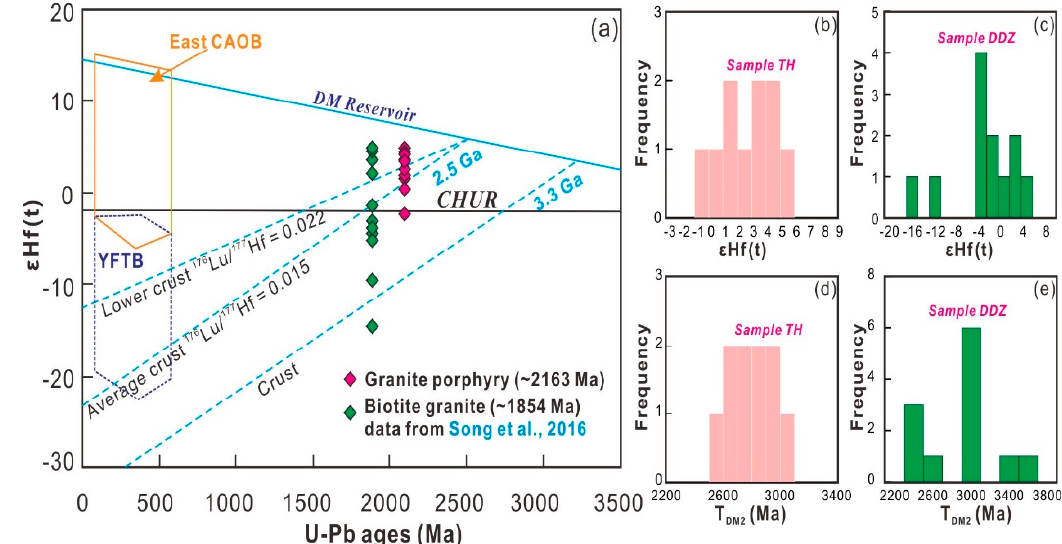
Figure 8. The ε Hf(t) vs. U-Pb ages (Ma) diagram for the Paleoproterozoic igneous rocks from the Qingchengzi district. Abbreviations: YFTB = Yanshan fold and thrust belt (Yang et al. [59]); CAOB = Central Asian Orogenic Belt; CHUR = chondritic uniform reservoir; DM = depleted mantle. ( a ) ε Hf(t) vs. U-Pb ages (Ma) diagram, ( b , c ) Histograms of ε Hf(t) values, ( d , e ) Histograms of T DM2 ages.